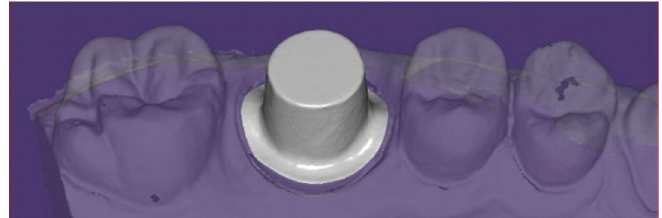
Figure 3. Scanned images were imported in Exocad CAD/CAM software and managed by a technician for core designing.